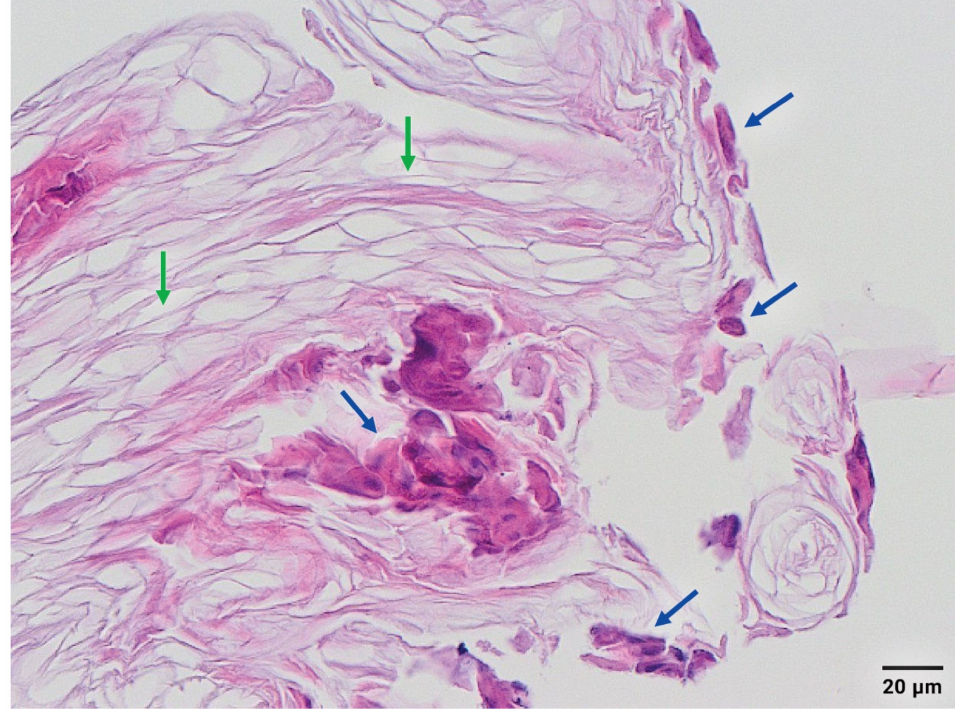
Figure 2. Histology of staphylococcal scalded skin syndrome. Microscopical picture of the snap- frozen blister roof biopsy, showing only horn lamellae of the stratum corneum (green arrow) and some acantholytic epithelial cells (blue arrows) of the granular layer of the epidermis, compatible with